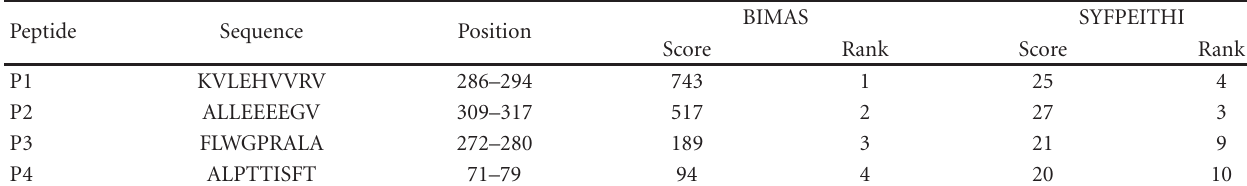
Table 1: Predicted HLA-A ∗ 0201-restricted CTL epitopes by BIMAS and SYFPEITHI methods.